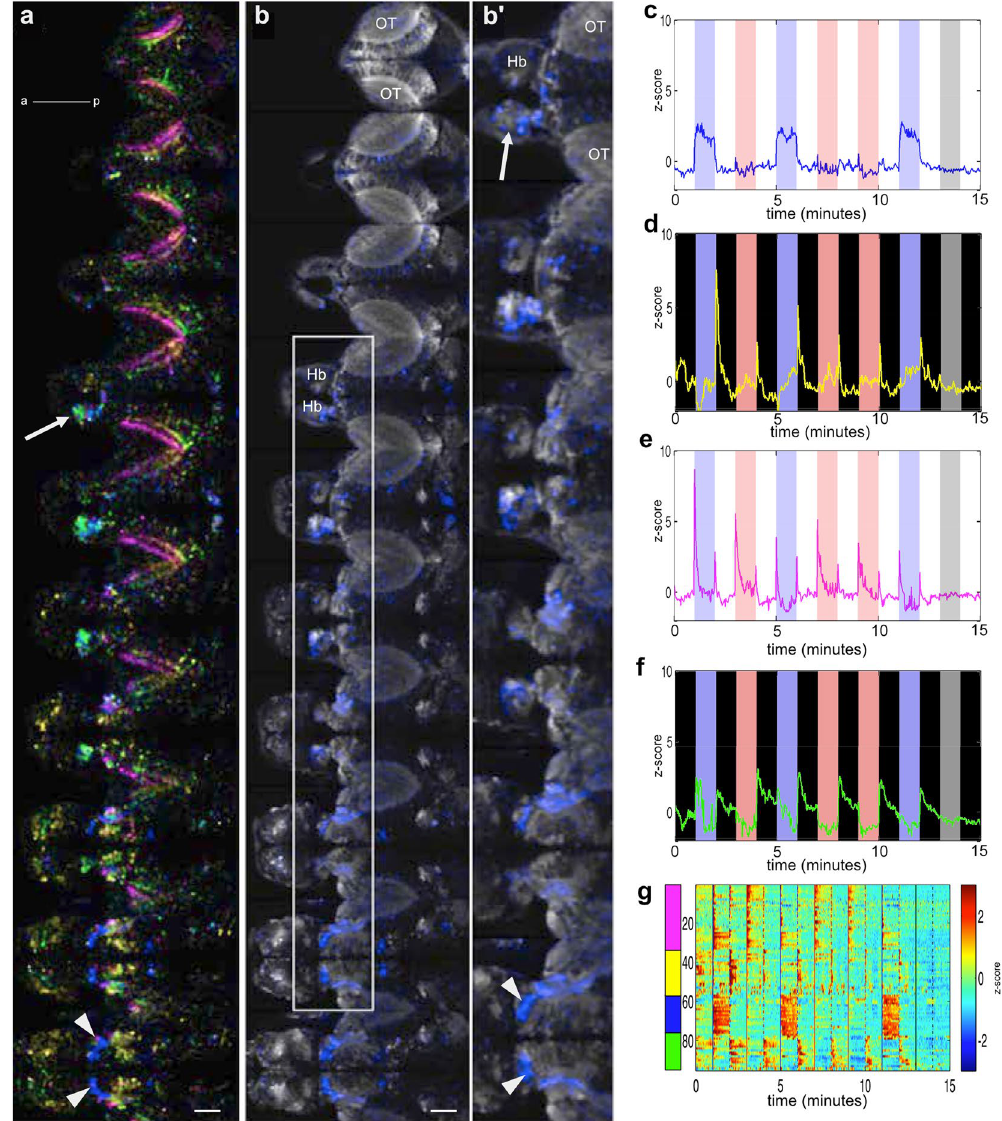
Figure 5. Overview of blue versus red light evoked activity in the brain. ( a ) Optical sections in a 6 dpf elavl3:GCaMP6f fish, going from dorsal to ventral. Each plane is separated by 10 µ m. The area imaged at each plane is 443.47 µ m x 222.73 µ m. ( b ) Distribution of light-evoked activity in one fish, generated from ICA spatial maps. The white arrowheads indicate the thalamus, while the arrow indicates the habenula. ( b ) A magnified view of the area boxed in panel (b). (c – f) Different classes of responses, obtained by PCA followed by ICA. The same colours are used in panel (b). The blue and red bars indicate the periods that blue or red light was delivered. ( g ) Light-evoked activity in segmented ROIs, which were derived from ICA spatial maps. OT: optic tectum; Hb: habenula; a: anterior; p: posterior. Gamma of 0.65 was applied to panels (a and b). Scale bar = 50 µ